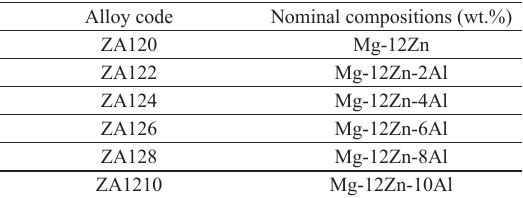
Table 1. Chemical compositions of the investigated alloys Alloy code